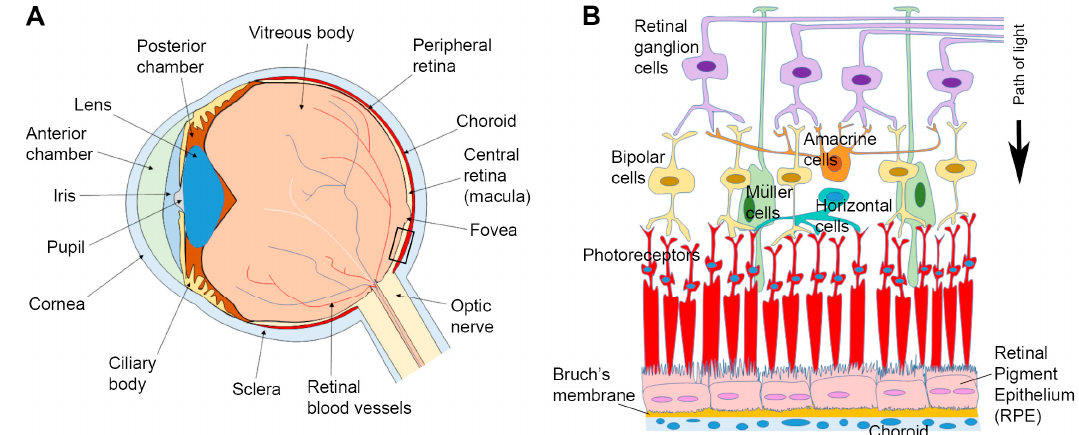
Figure 1. Anatomy of the eye and arrangement of cells in the retina and associated tissues. ( A ) Schematic diagram of the eye in cross-section. ( B ) Enlargement of the area indicated in box ( A ) showing relative position of the Retinal Pigment Epithelium (RPE) in relation to other tissues. Sandwiched between the overlying neuroretina and the underlying Bruch’s membrane/choroid, the RPE monolayer marks the important blood-retinal-barrier. A black arrow indicates the pathway of light.